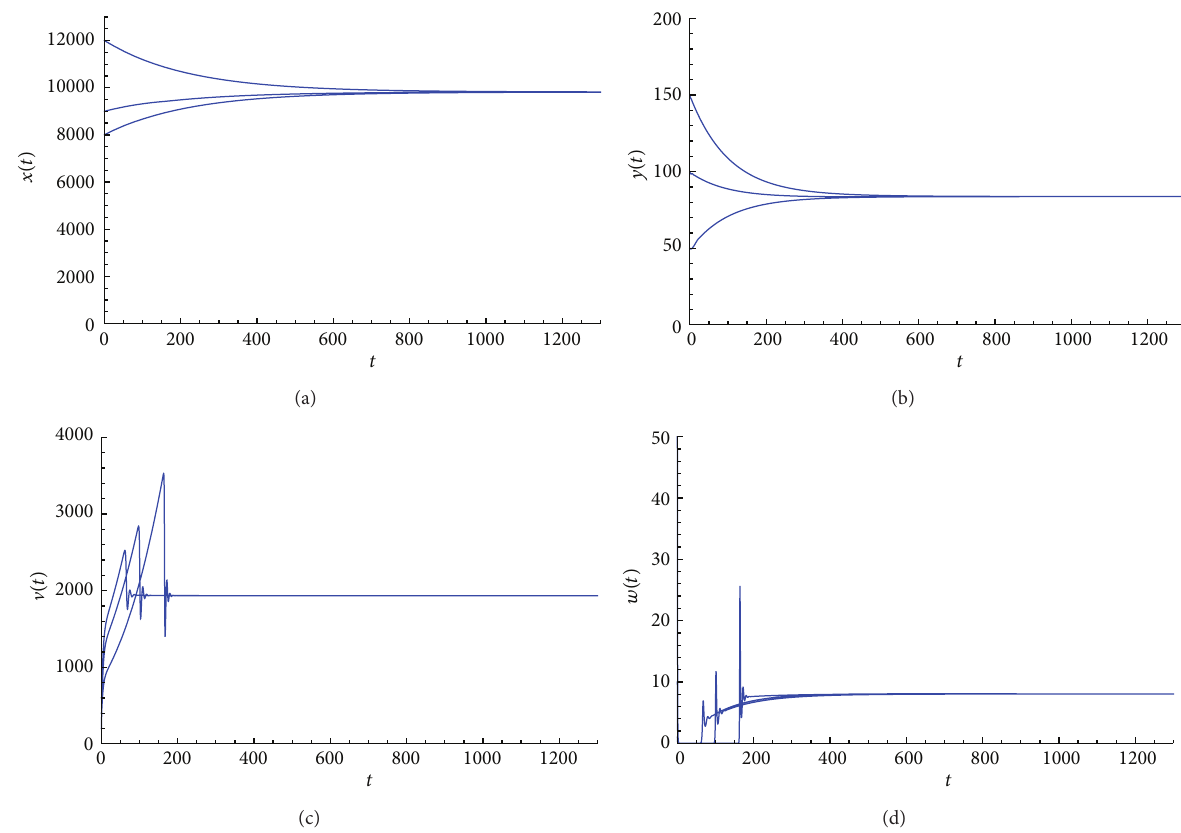
Figure 3: Trajectories of 𝑥(𝑡),𝑦(𝑡), V (𝑡),𝑤(𝑡) for R 1 0 = 2.15743 and R 1 1 = 2.05092 , and 𝐸 2 = (9818.03, 83.7059, 1933.33, 8.0456) are globally asymptotically stable. 𝑥(𝑡) , 𝑦(𝑡) , V (𝑡) , and 𝑤(𝑡) versus 𝑡 are illustrated by (a), (b), (c), and